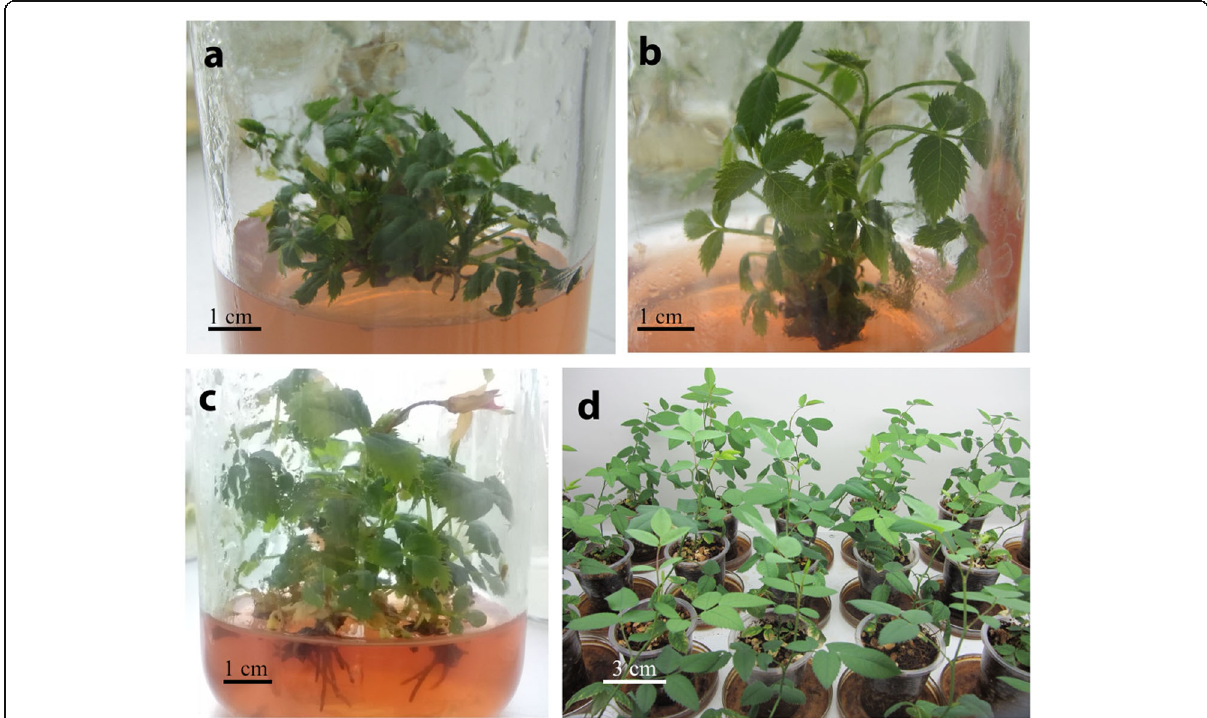
Fig. 2 In vitro propagation of Rosa canina using nodal explants as affected by various growth additives. a Shoot proliferation of nodal explants incubated in VS medium + 600 mg/l casein hydrolysate. b Shoot proliferation of nodal explants incubated in VS medium + 50 mg/l silver nitrate. c Root induction on VS medium + 0.3 mg/l NAA. d Acclimatized plantlets after 1 month in ex vitro